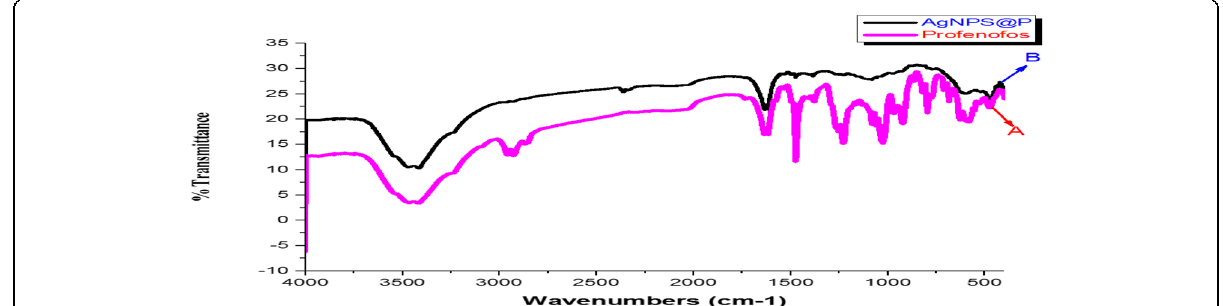
Fig. 3 The Fourier transform-infrared (FT-IR) spectra for (A) profenofos and (B) AgNPS@P